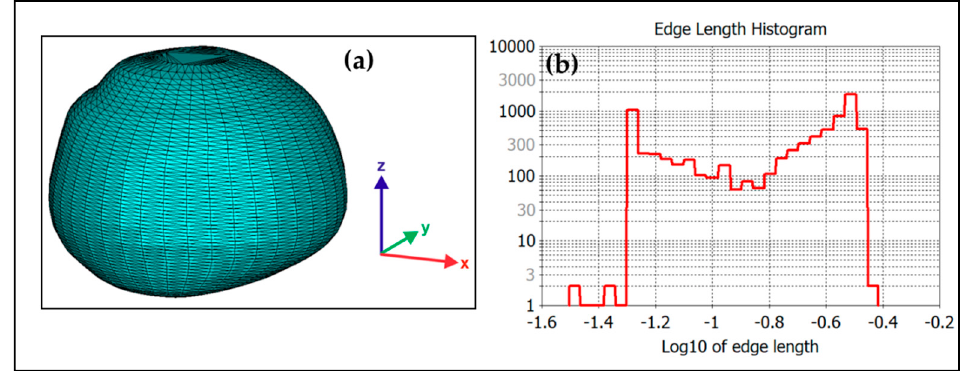
Figure 3. ( a ) Triangle mesh of an individual drop imported into CST Microwave Studio; ( b ) histogram of the edge length of the